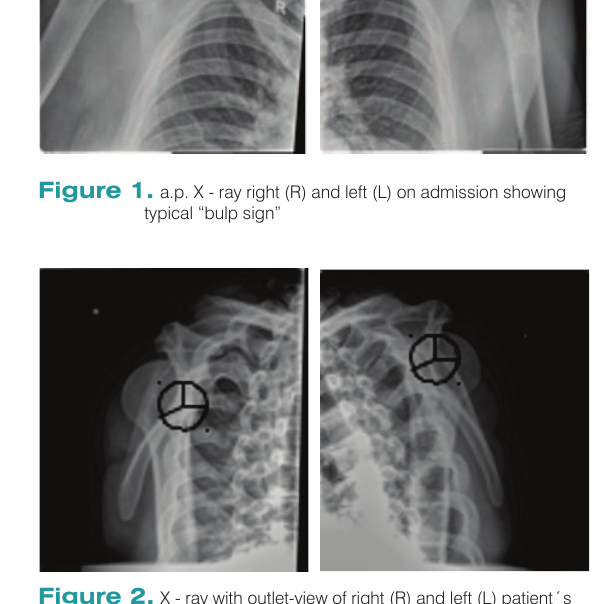
Figure 4. X - ray of both shoulders after closed reduction and fixa - tion of the AC-joint showing physiological joint